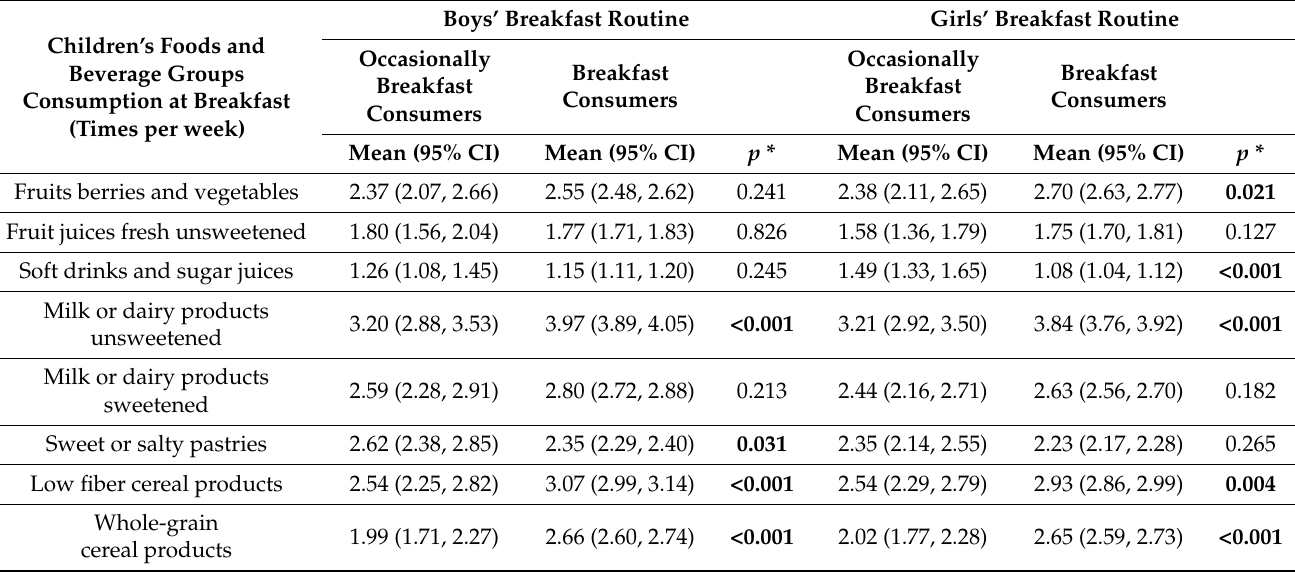
Table 5. Analysis of covariance between food and beverage consumption at breakfast and breakfast routine in children, stratified by gender.